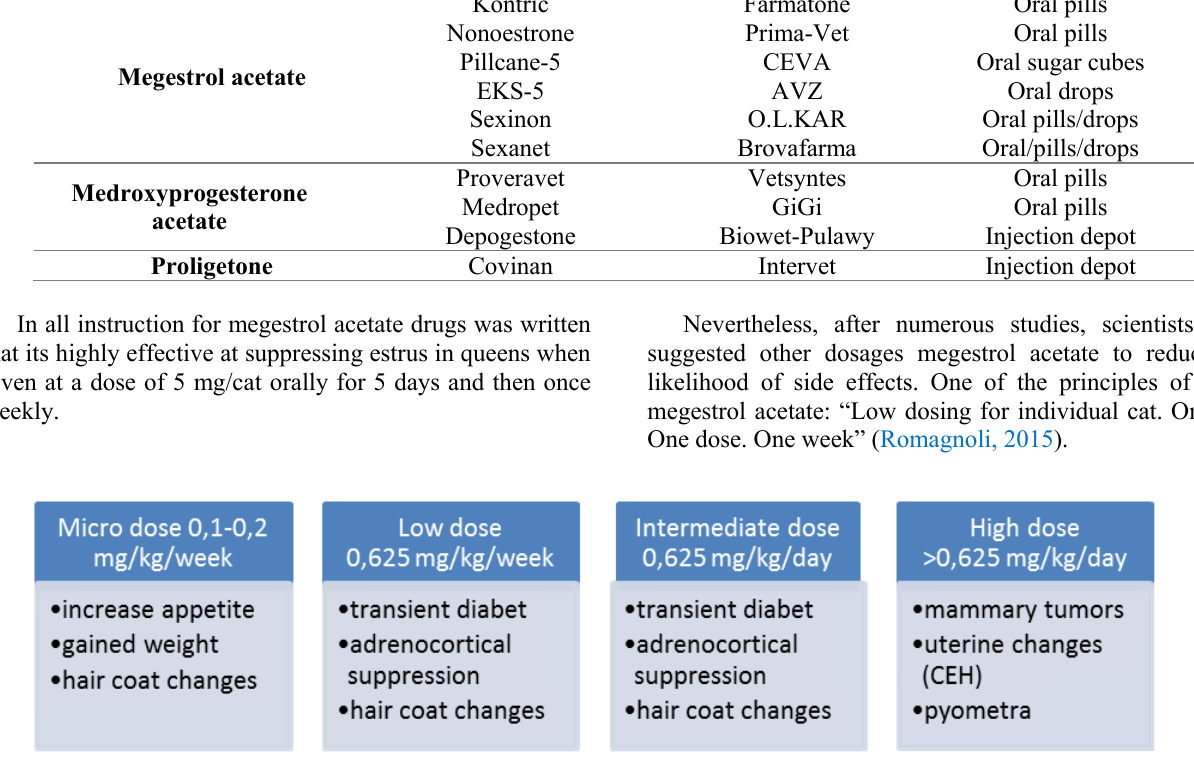
Fig. 1. Scheme of megestrol acetate dosage and side effects in